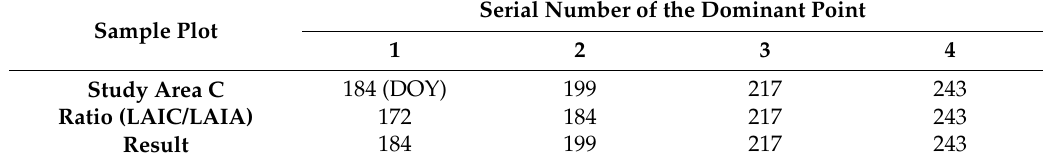
Table 5. Position of the dominant points in two different curves and the determination of the dominant points.